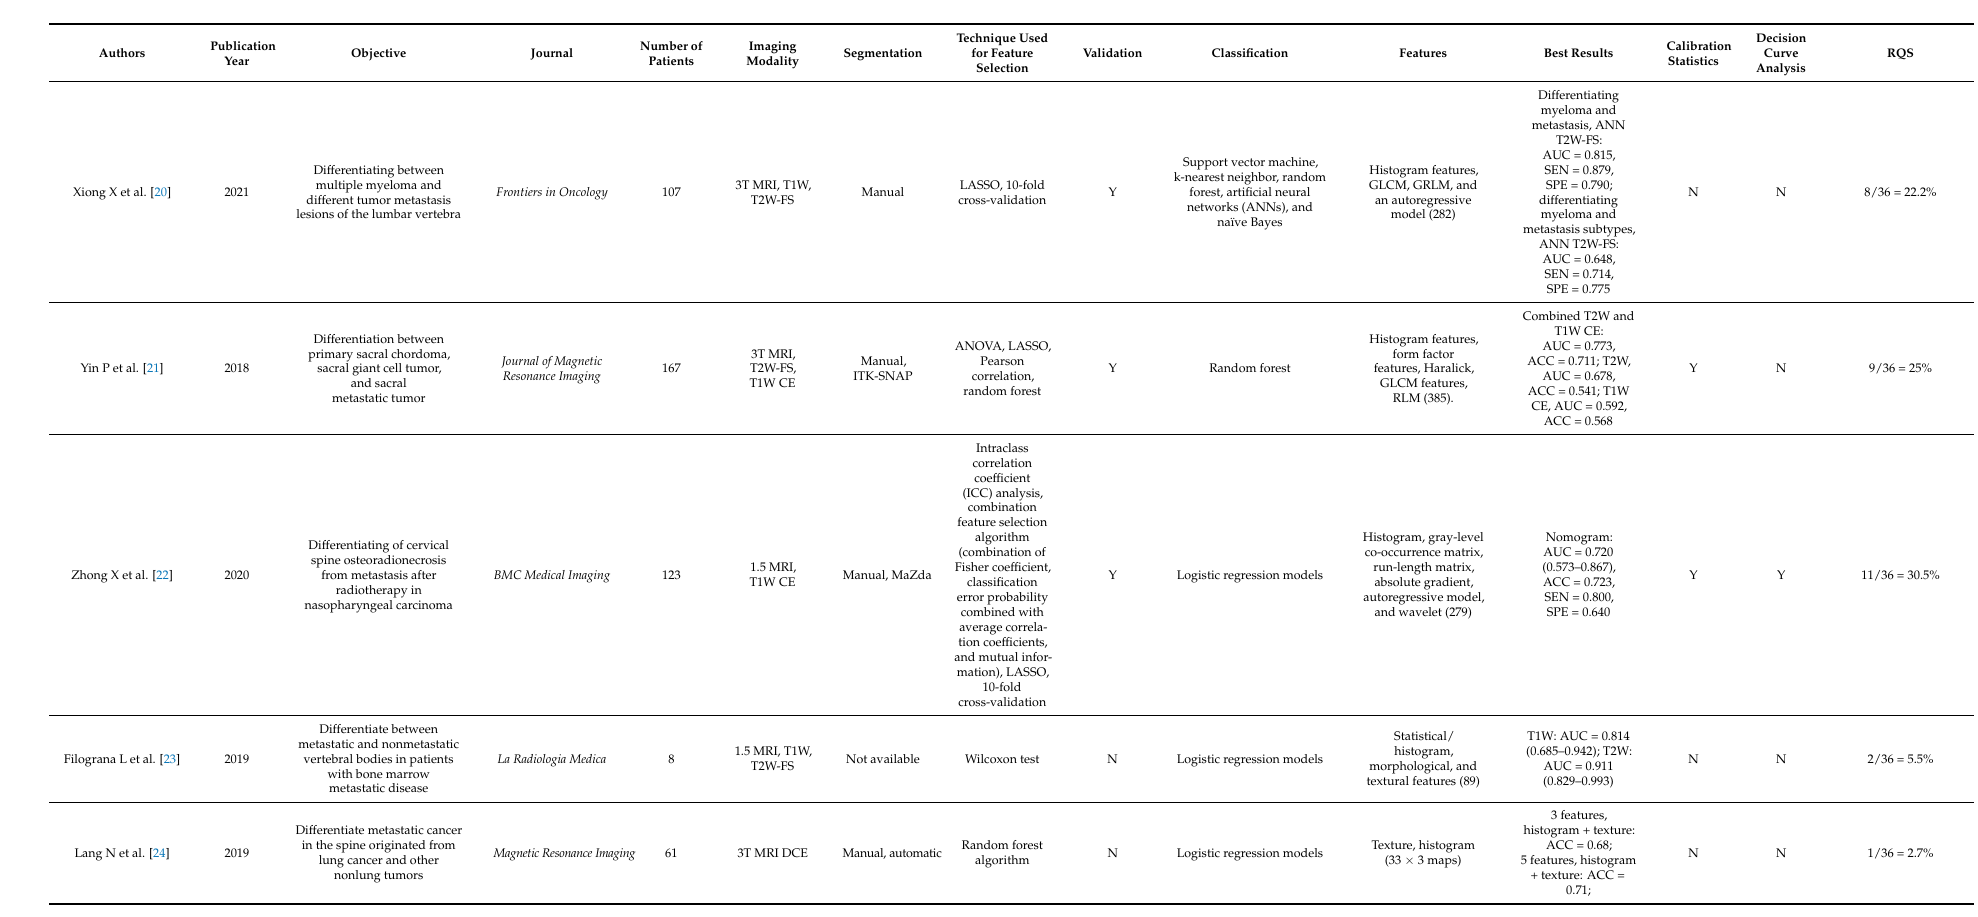
(ICC)analysis, combination featureselection algorithm (combinationof Fishercoefficient, classification errorprobability